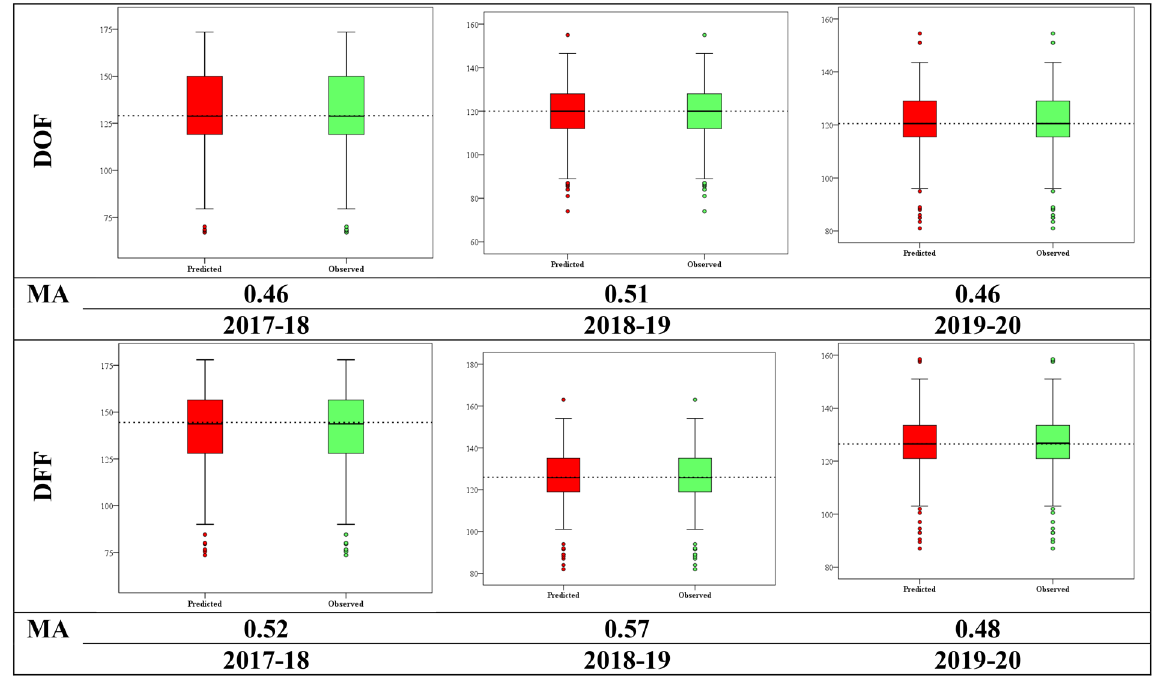
Figure 5. Box plot of observed traits vs. predicted flowering days through genomic prediction using RRBLUP method across different year’s data. The middle line in each box is the median value. Model accuracy (MA) is provided by setting 80:20 training and testing data